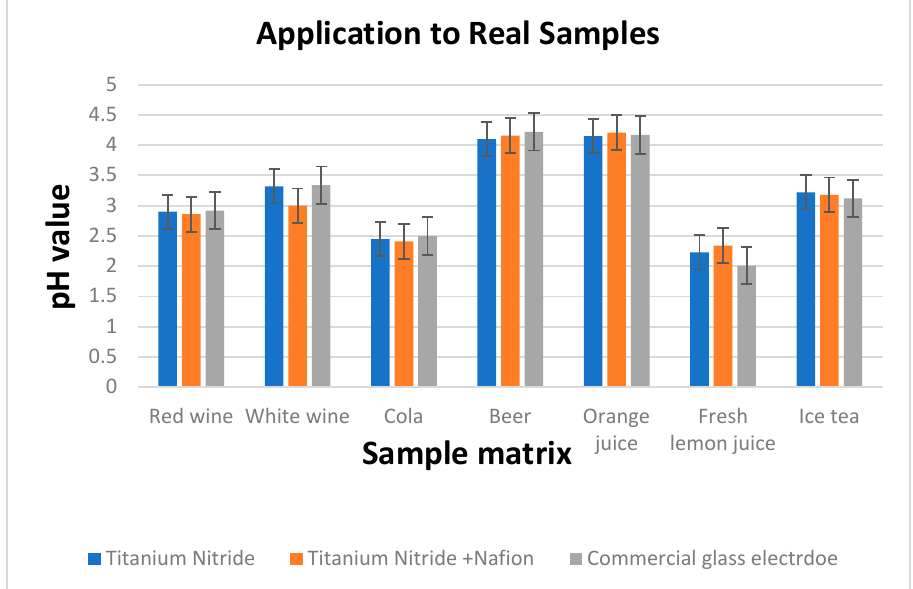
Figure 4. pH values determined using 85 nm TiN electrode with the developed TiN + Nafion and using a commercial glass pH sensor for seven samples.